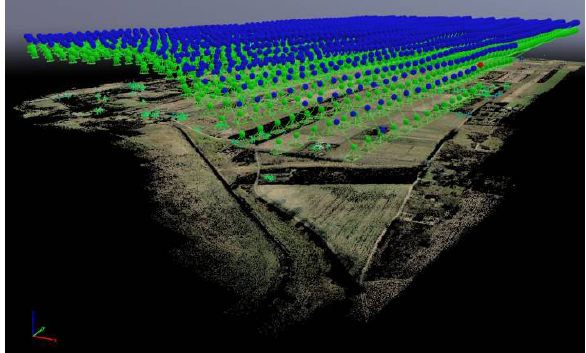
Figure 2. The perspective view of UAS images registered for the test area with visible tie-points For the measurements of boundary points, the monoplotting of digital orthophotomaps generated from UAS images was selected as a leading measurement technique based on aerial photogrammetry. It meets the legal accuracy requirements of the planimetric point localization with an error value lower than 0.30 m regarding the points of the first-class geodetic